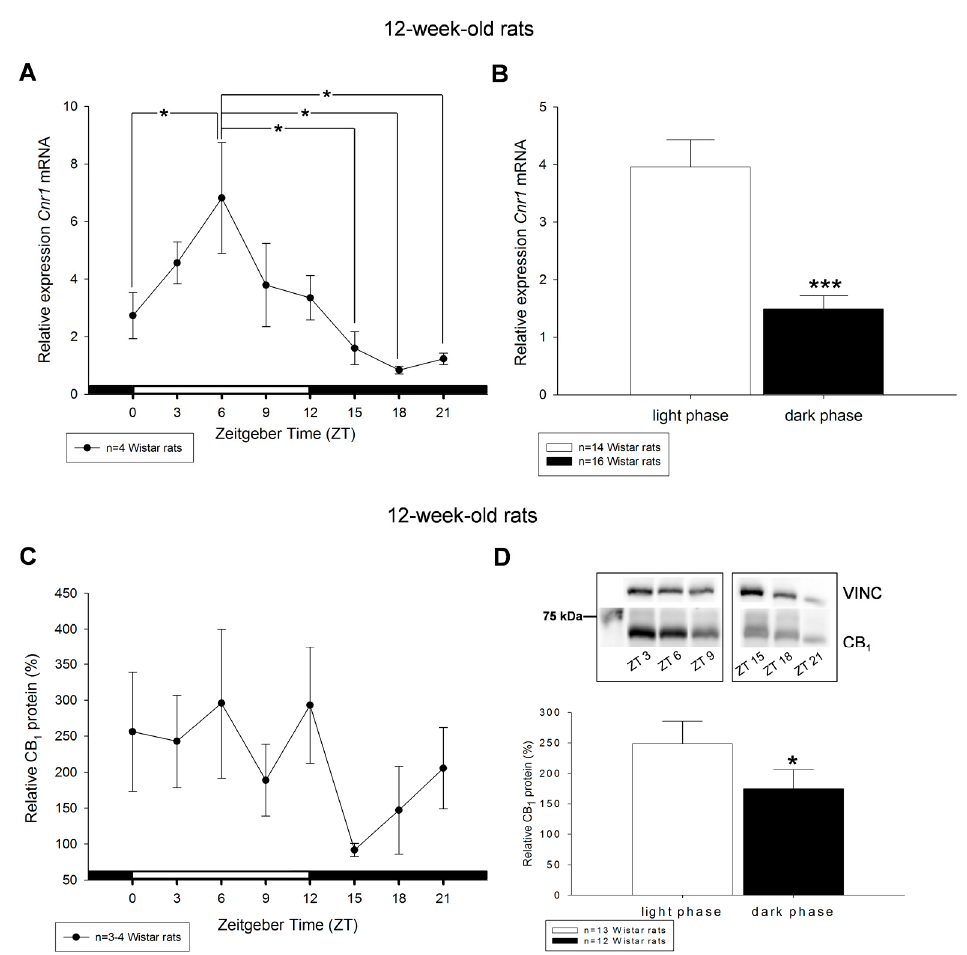
Figure 3. Diurnal profiles of cannabinoid receptor Cnr1 mRNA ( A ) and CB 1 protein ( C ) in liver of 12-week-old rats are shown. Diurnal differences were analyzed by Mann–Whitney test; * p < 0.05, *** p < 0.001. Values of light phase as well as those of dark phase are summarized for Cnr1 mRNA ( B ) and CB 1 protein ( D ). The insets in ( D ) illustrate the detection of single band of 64 kDa of CB 1 via Western blotting in liver tissue obtained from the middle of the day respective night. Vinculin (VINC) was used as control protein.